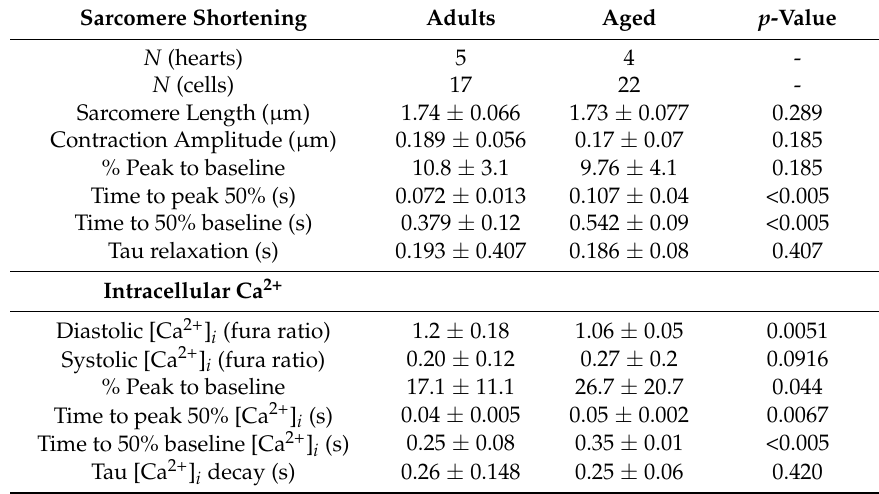
Table 2. Baseline values for sarcomere shortening and intracellular calcium of isolated myocytes (mean ± standard